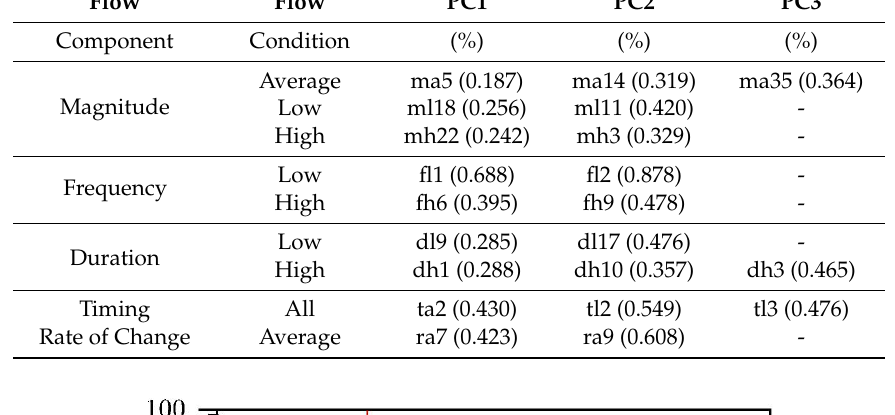
Table 6. A minimum subset of hydrologic indices with the greatest absolute loadings (%) of each principal component axis (PC1–PC3) representing each major element of a reference flow regime in Hinkson Creek, MO, USA. Definitions of hydrologic indices are located in Table 2.